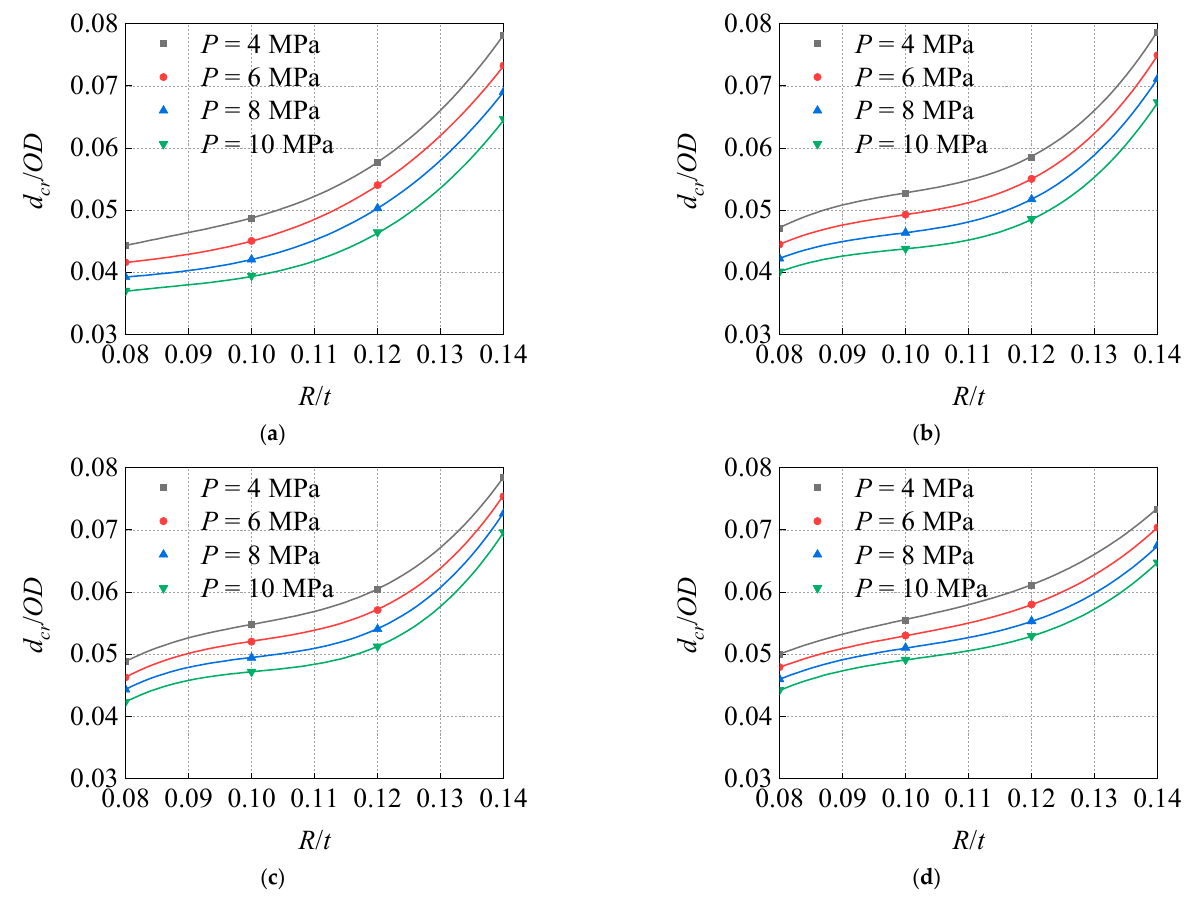
Figure 19. Influence of indenter radius on critical dent depths under different pressure: ( a ) OD / t = 65.04, ( b ) OD / t = 57.25, ( c ) OD / t = 50.81, ( d ) OD / t = 46.46.